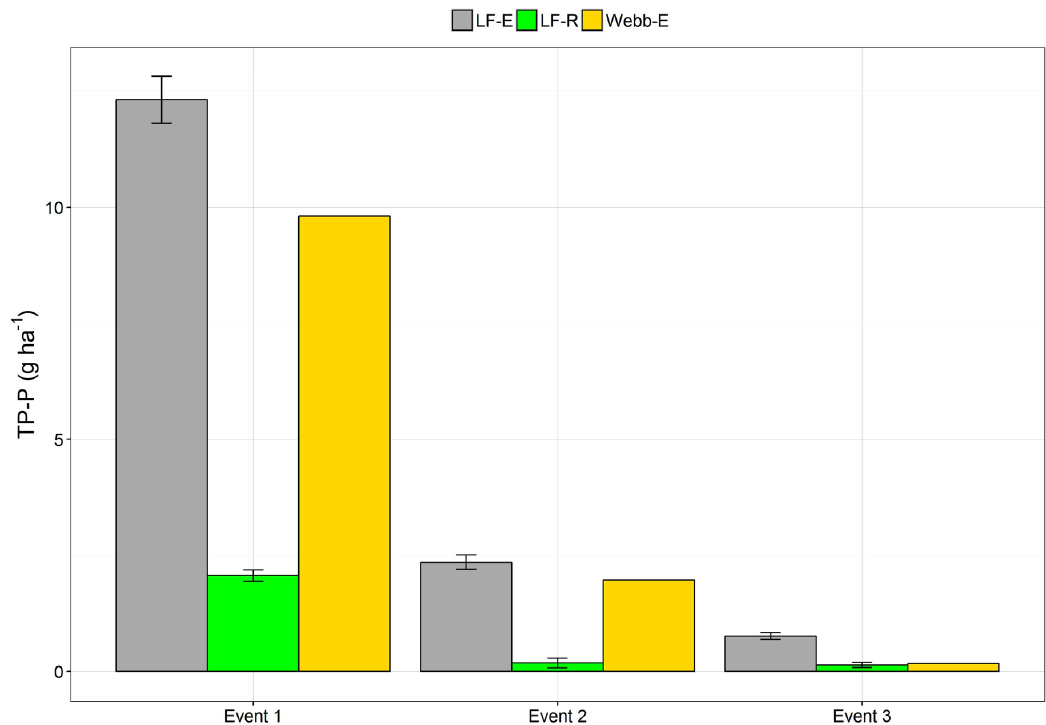
Figure 4. Predicted TP-P export fluxes for three monitored events for the different groups of load calculation methods; the error bars indicate the differences between the three best load calculation models based on the validation. For Webb-E, no validation was possible due to the method.